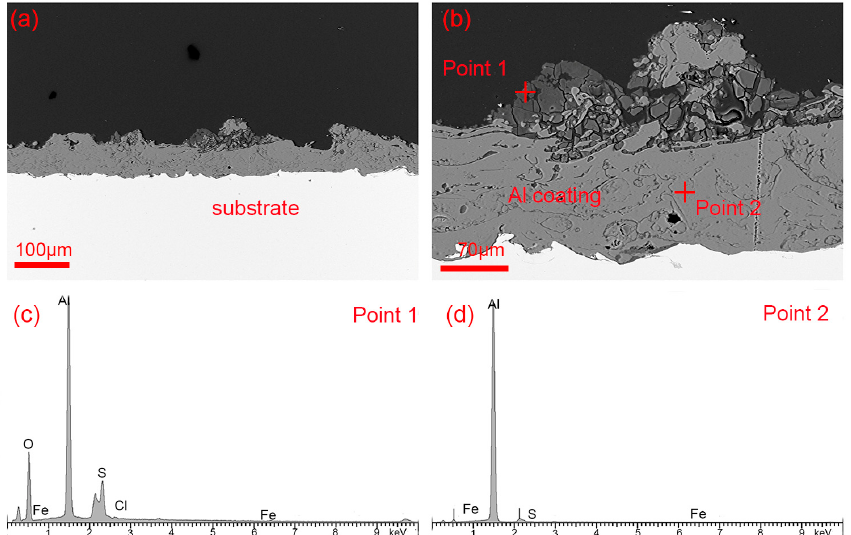
Figure 8. ( a , b ) SEM micrograph of the Al coating sample (~0.15 mm) after the immersion test for 3 months. EDS results of some areas in the figure are provided in ( c , d ). 3 months. EDS results of some areas in the figure are provided in ( c , d